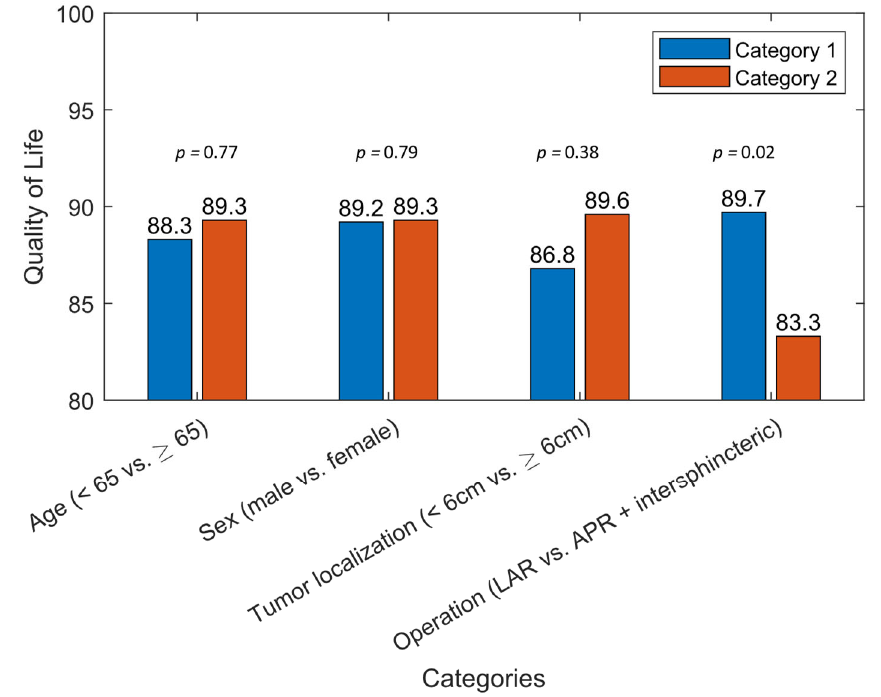
Figure 1. Results of the EORTC QLQ-C30 in relation to risk factors in the univariate analysis for sexual dysfunction after multimodal therapy of rectal cancer.